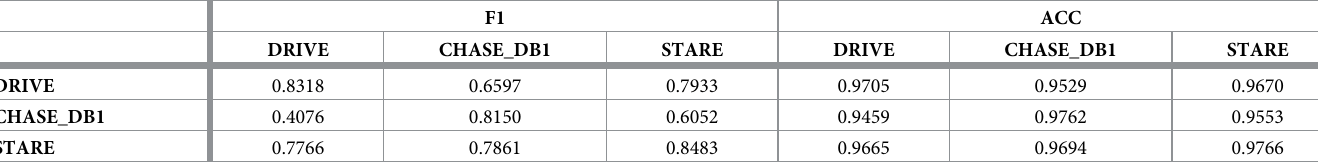
Table 7. Cross test